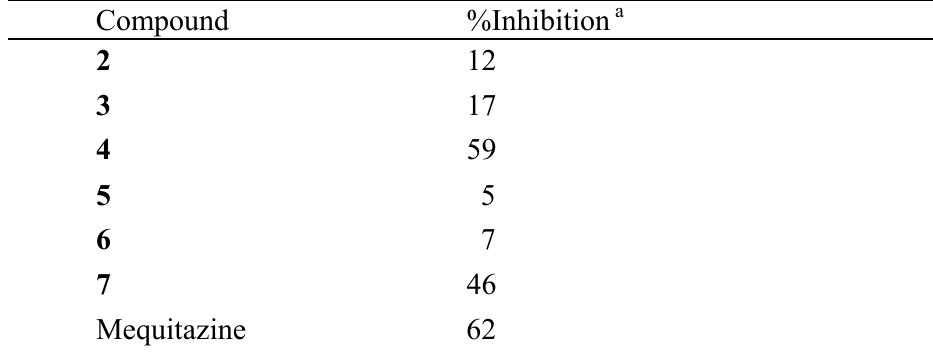
Table 2. Effects of hesperetin α -glycosides 2 - 7 on O 2- generation from rat